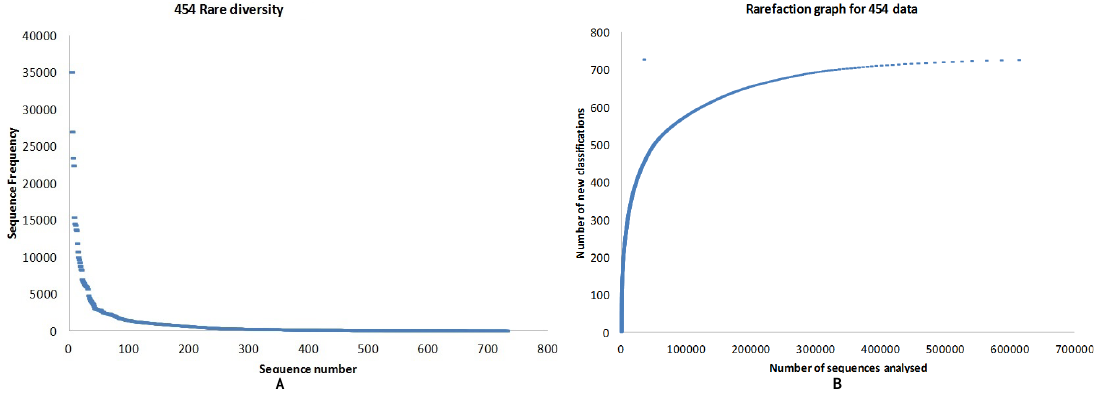
Figure 2. Pie chart representing the number of bacterial genera identified by 454 pyrosequencing. Microorganisms 2016 , 4